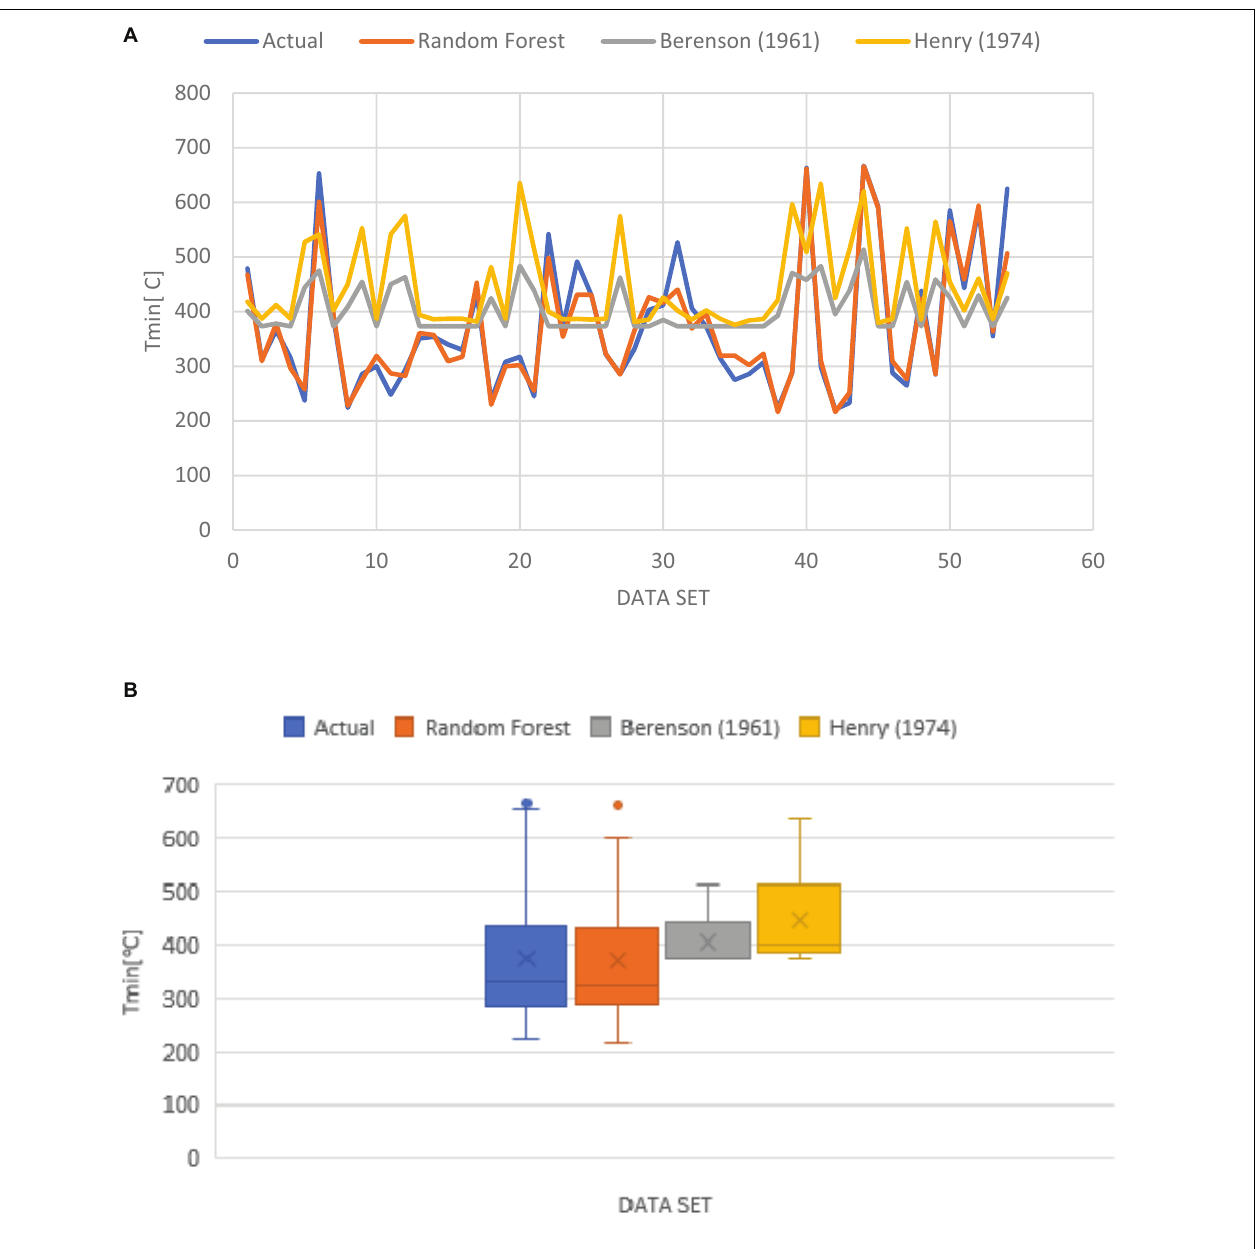
FIGURE 6 | (A) Comparing different models against actual data output. (B) Results obtained by different models compared to actual data output using box and whisker